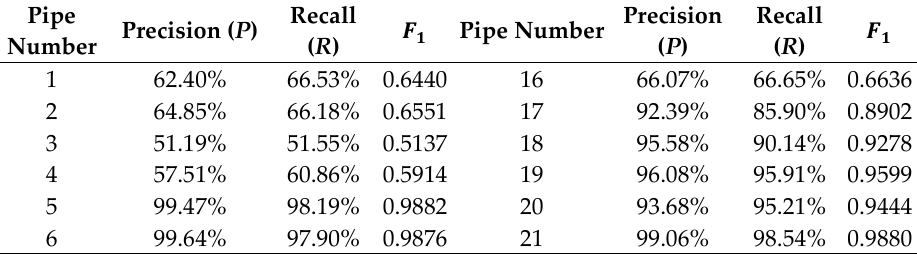
Table 5. First-stage LFD model’s average performance